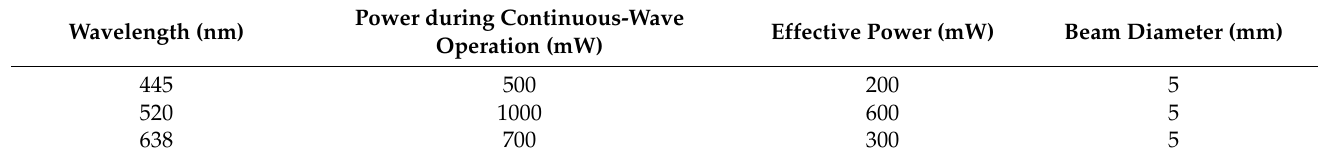
Table 2. Basic information about laser